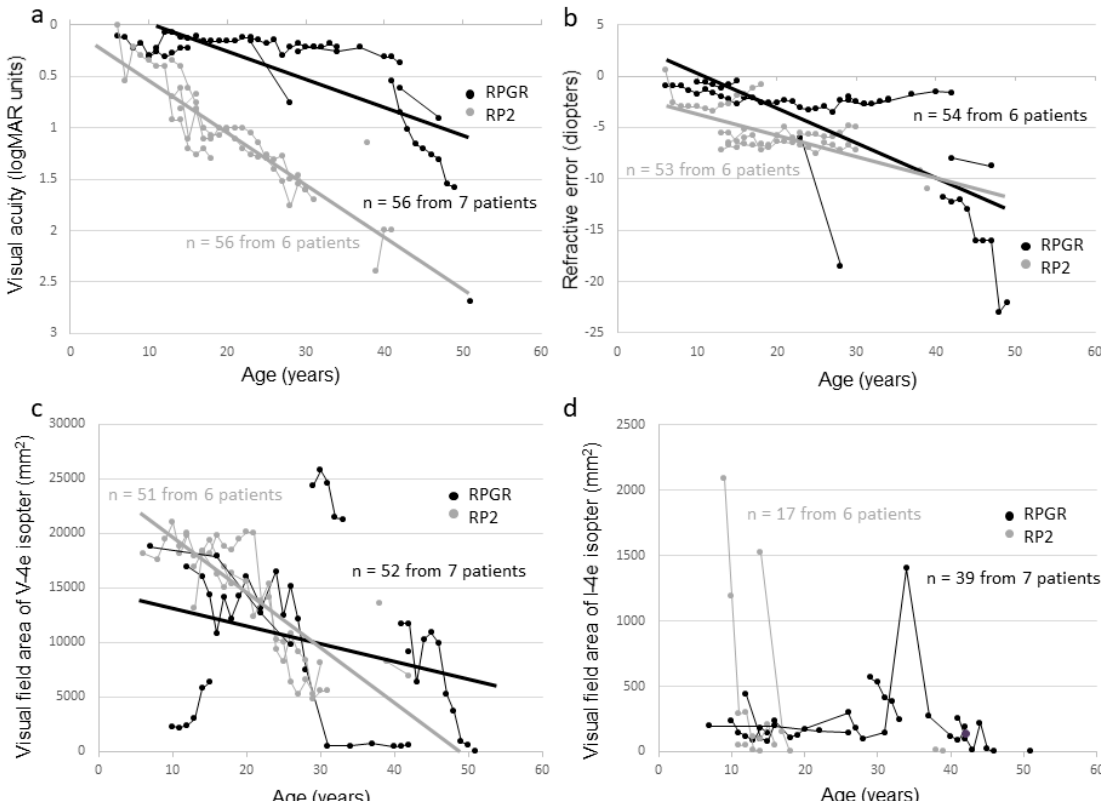
Figure 5. Correlation between visual function and age among affected male subjects with RPGR or RP2 mutation. Black dots and lines indicate the data of affected male subjects with RPGR mutation and gray dots and lines indicate the data of affected male subjects with RP2 mutation. The graphs show visual acuity values expressed in logMAR units ( a ), refractive error ( b ), visual field extent with the V-4e isopter ( c ), and visual field extent with the I-4e isopter ( d ) versus age. The data from the same subject are indicated using bars connecting the points.